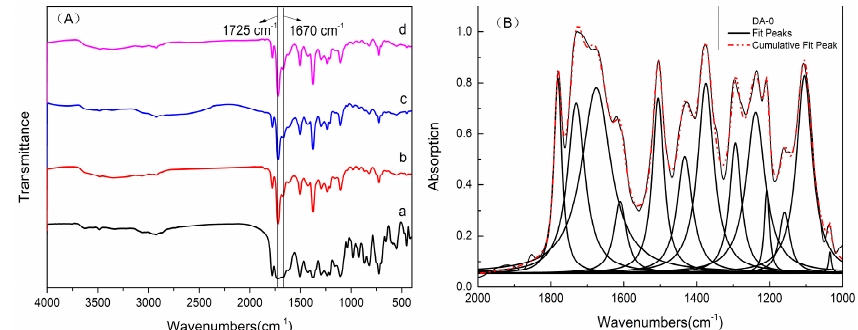
Figure 1. ( A ) FTIR spectra of polyimide based on 3,3 ′ ,4,4 ′ -benzophenonetetracarboxylic dianhydride and 3,3 ′ -dimethyl-4,4 ′ -diaminodiphenyl methane (BTDA-DMMDA PI) films peeled from liquid crystal (LC) cells with different weight ratios of dodecyl acrylate (DA) monomers: a: DA-0, b: DA-2, c: DA-1, and d: DA-0.5; ( B ) FTIR spectrum a (black line) and its peek fitted with Lorentzian functions curves (red dash line and bold black lines).